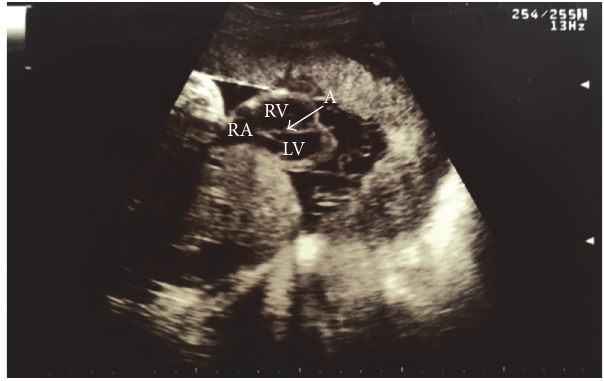
Figure 2: Ultrasound of fetus heart at 42nd week of gestation with ventricular septal defect. RA: right atrium, RV: right ventricle, and LV: left ventricle. A: ventricular septal defect.